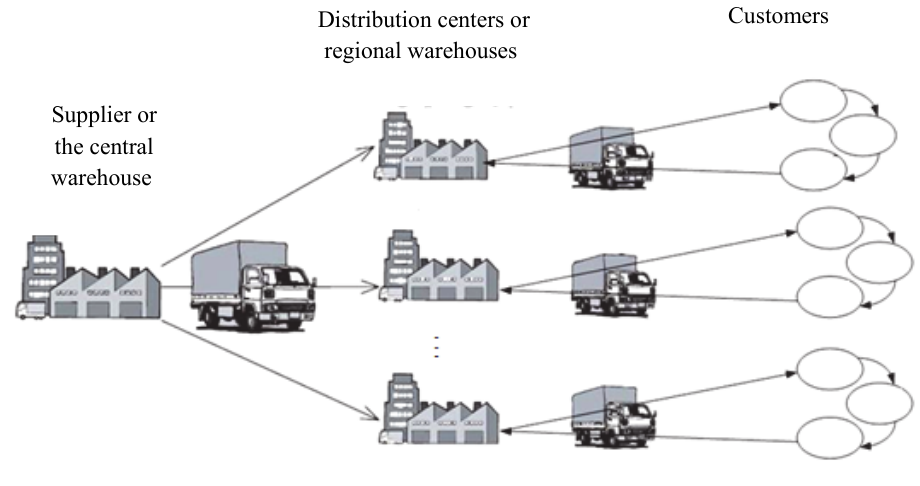
Fig. 1. structure of the